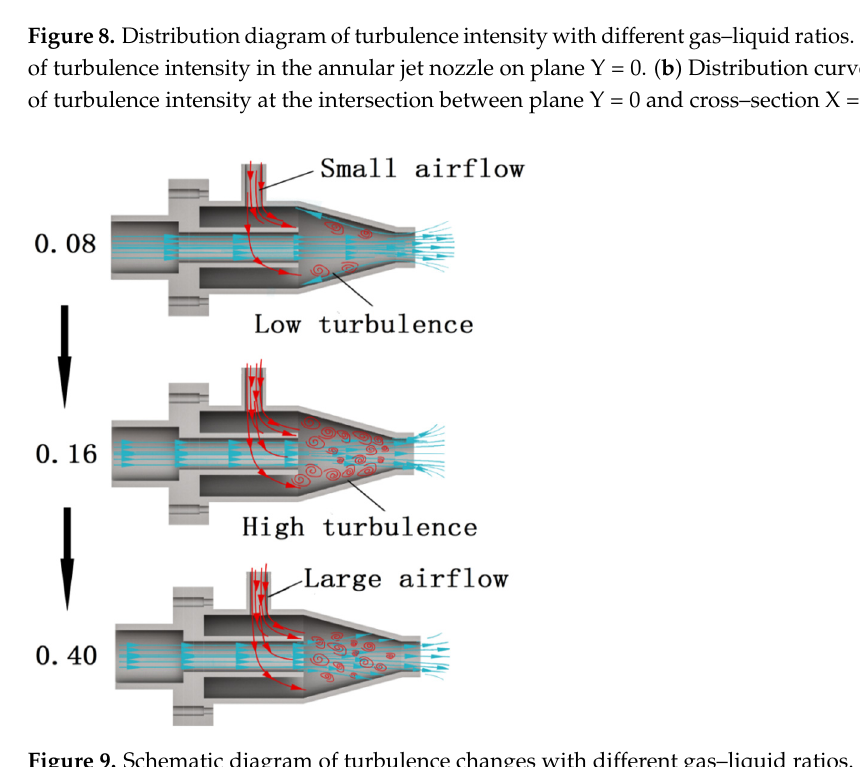
Figure 9. Schematic diagram of turbulence changes with different gas–liquid ratios.